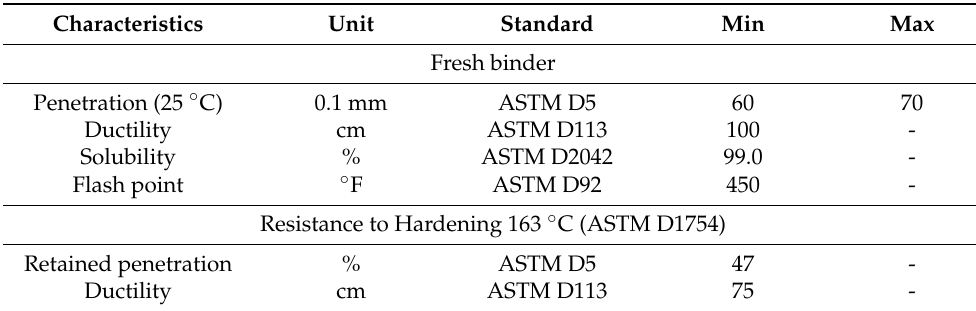
Table 1. Technical specifications of the bitumen used.